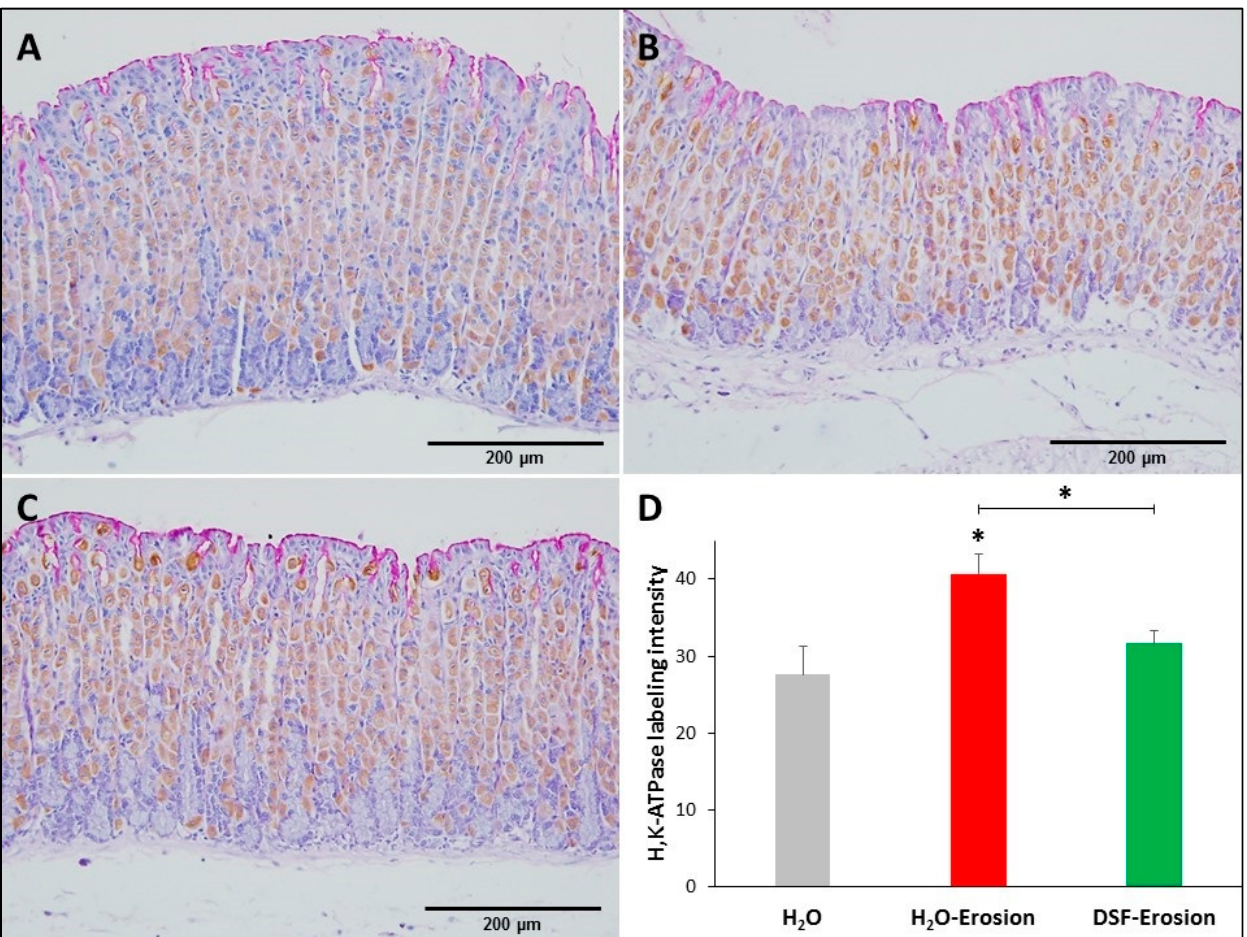
Figure 5. H + ,K + -ATPase immunolabeling in the gastric mucosae of H 2 O control ( A ), erosion-induced ( B ) and DSF-pretreated then erosion-induced ( C ) mice. The tissue sections were counterstained with hematoxylin and PAS. Specific antibodies against H + ,K + -ATPase β -subunit were used to label parietal cells distributed throughout the gastric glands. ( D ) Quantification of H + ,K + -ATPase labeling intensity per field is presented from three mice in each group as mean ± SE. * p < 0.05; scale bar = 200 µm.